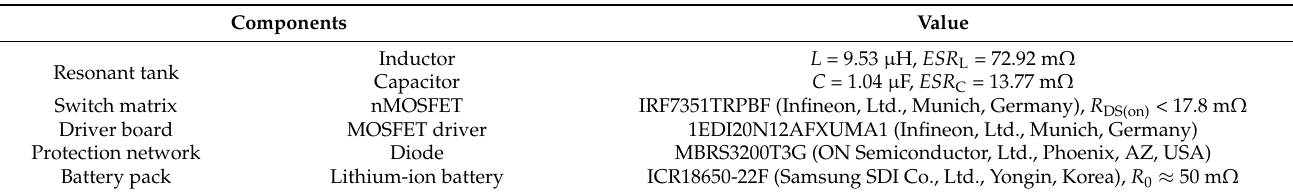
Figure 13. Experimental prototype of the proposed BRLCC equalizer. ( a ) Platform. ( b ) A single board. Table 2. Parameters of the experimental